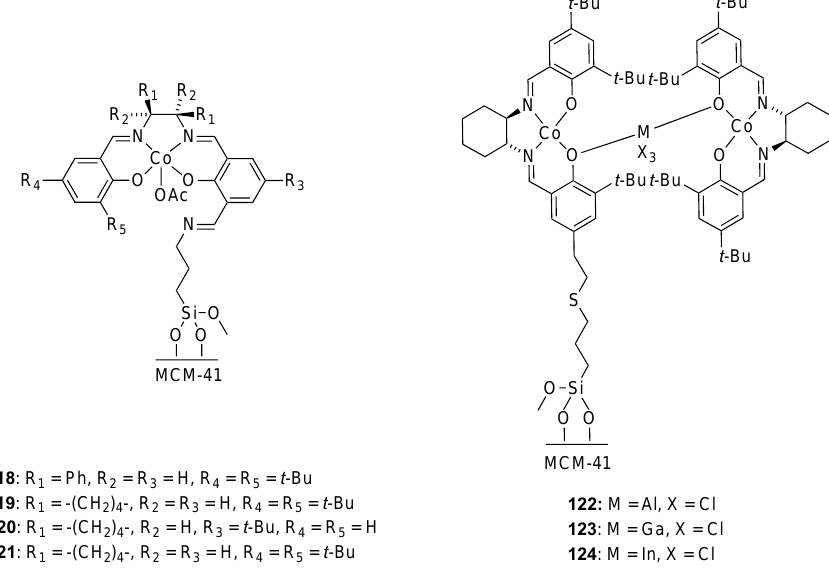
Figure 48. SBA-16-supported Co–salen catalyst 125 .